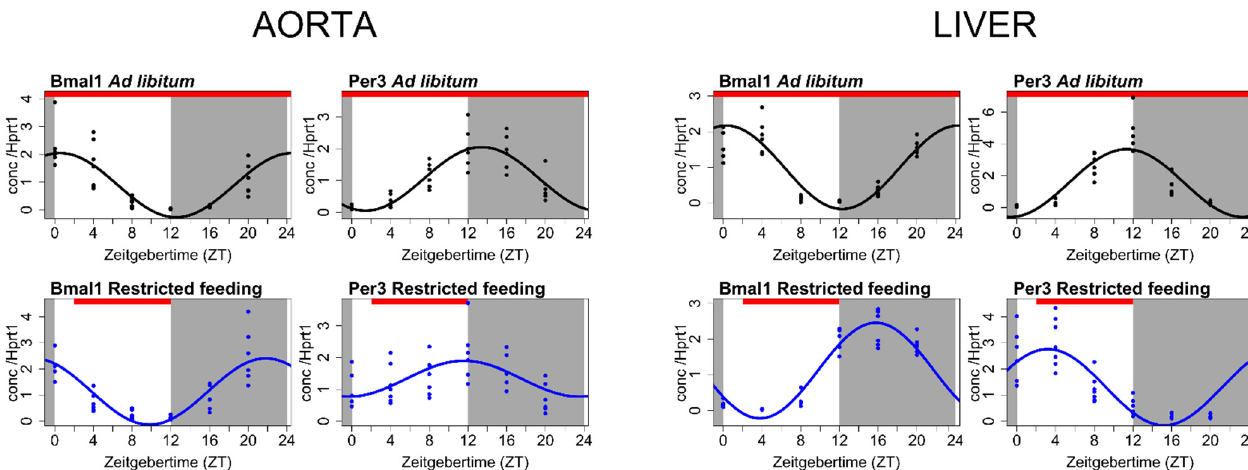
Figure 2. Differential effect of a feeding cue on the circadian clock in the aorta and liver. Many peripheral tissues are known to be entrained by the time of feeding, including the liver, a classical organ primarily responding to feeding cues rather than light input. The input of light and feeding were dissociated by restricting feeding to the habitual inactive period of the nocturnal rats (light period). The effect of restricted feeding on the circadian clock in the rat aorta and in the rat liver are shown. Expression of the core circadian clock genes Bmal1 and Per3 in the rat aorta (left) and liver (right) subjected to ad libitum feeding (top row, black, n = 38) and after 4 weeks of feeding restricted to ZT2-ZT12 (bottom row, blue, n = 39) was examined. As expected, the phase of the circadian clock in the liver was markedly shifted by restricted feeding. In contrast, the phase of the circadian clock in the aorta was not affected by the feeding time. Circadian rhythmicity was assessed by fitting data to a Cosinor regression model (solid lines). Gray areas indicate the dark period, and white areas indicate the light period. Zeitgeber time (ZT; “time-giver”) is the time since light onset. The red bar indicates the feeding time. Gene expression is normalized to the housekeeping gene Hprt1 .